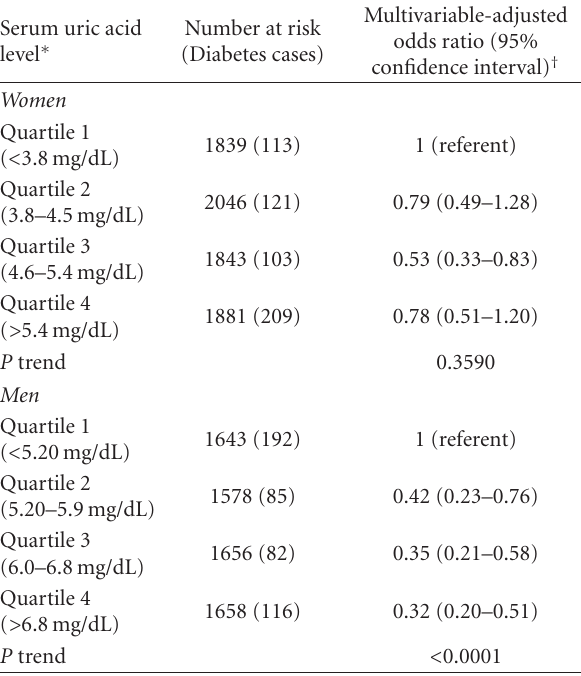
Table 4: Association between serum uric acid level and diabetes mellitus by